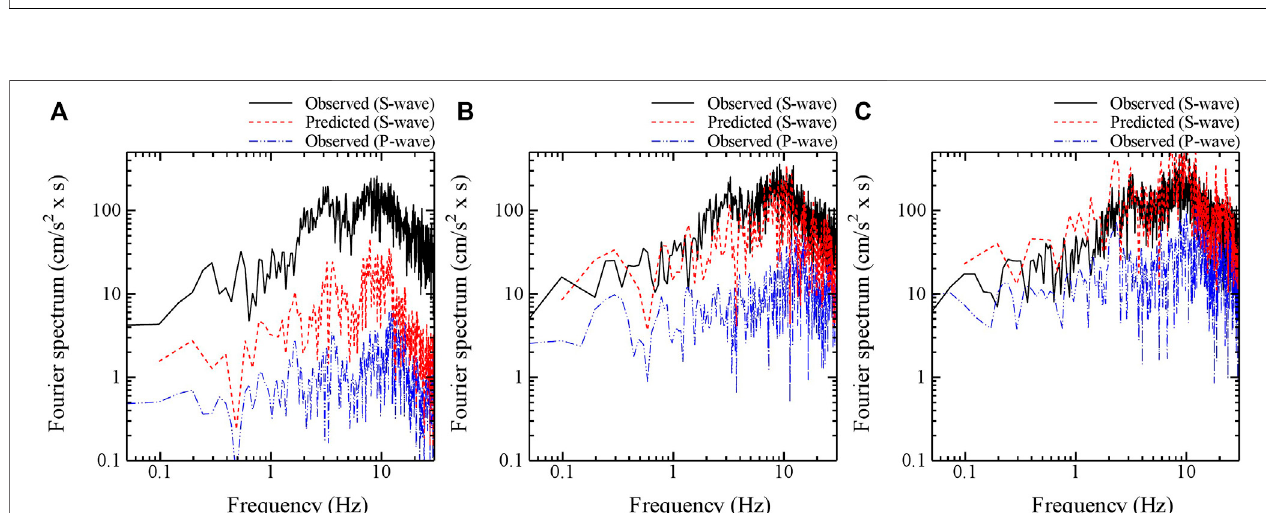
Frontiers in Earth Science |